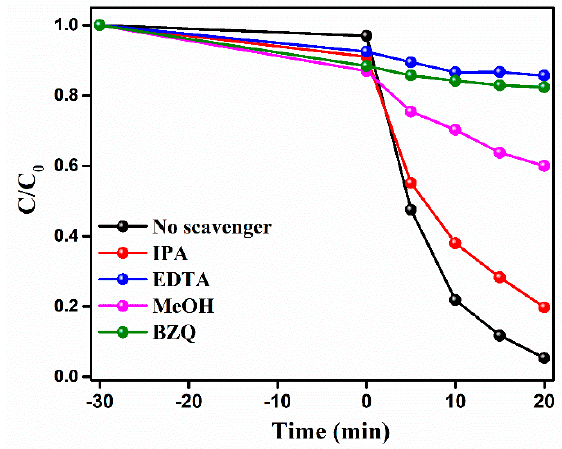
Figure 10. The photocatalytic degradation of BPA over BW3 with PMS activation in the presence of different scavengers. Reaction condition: initial BPA concentration of 10 mg/L, PMS dosage of 0.1 mmol/L, catalyst addition of 1 g/L.